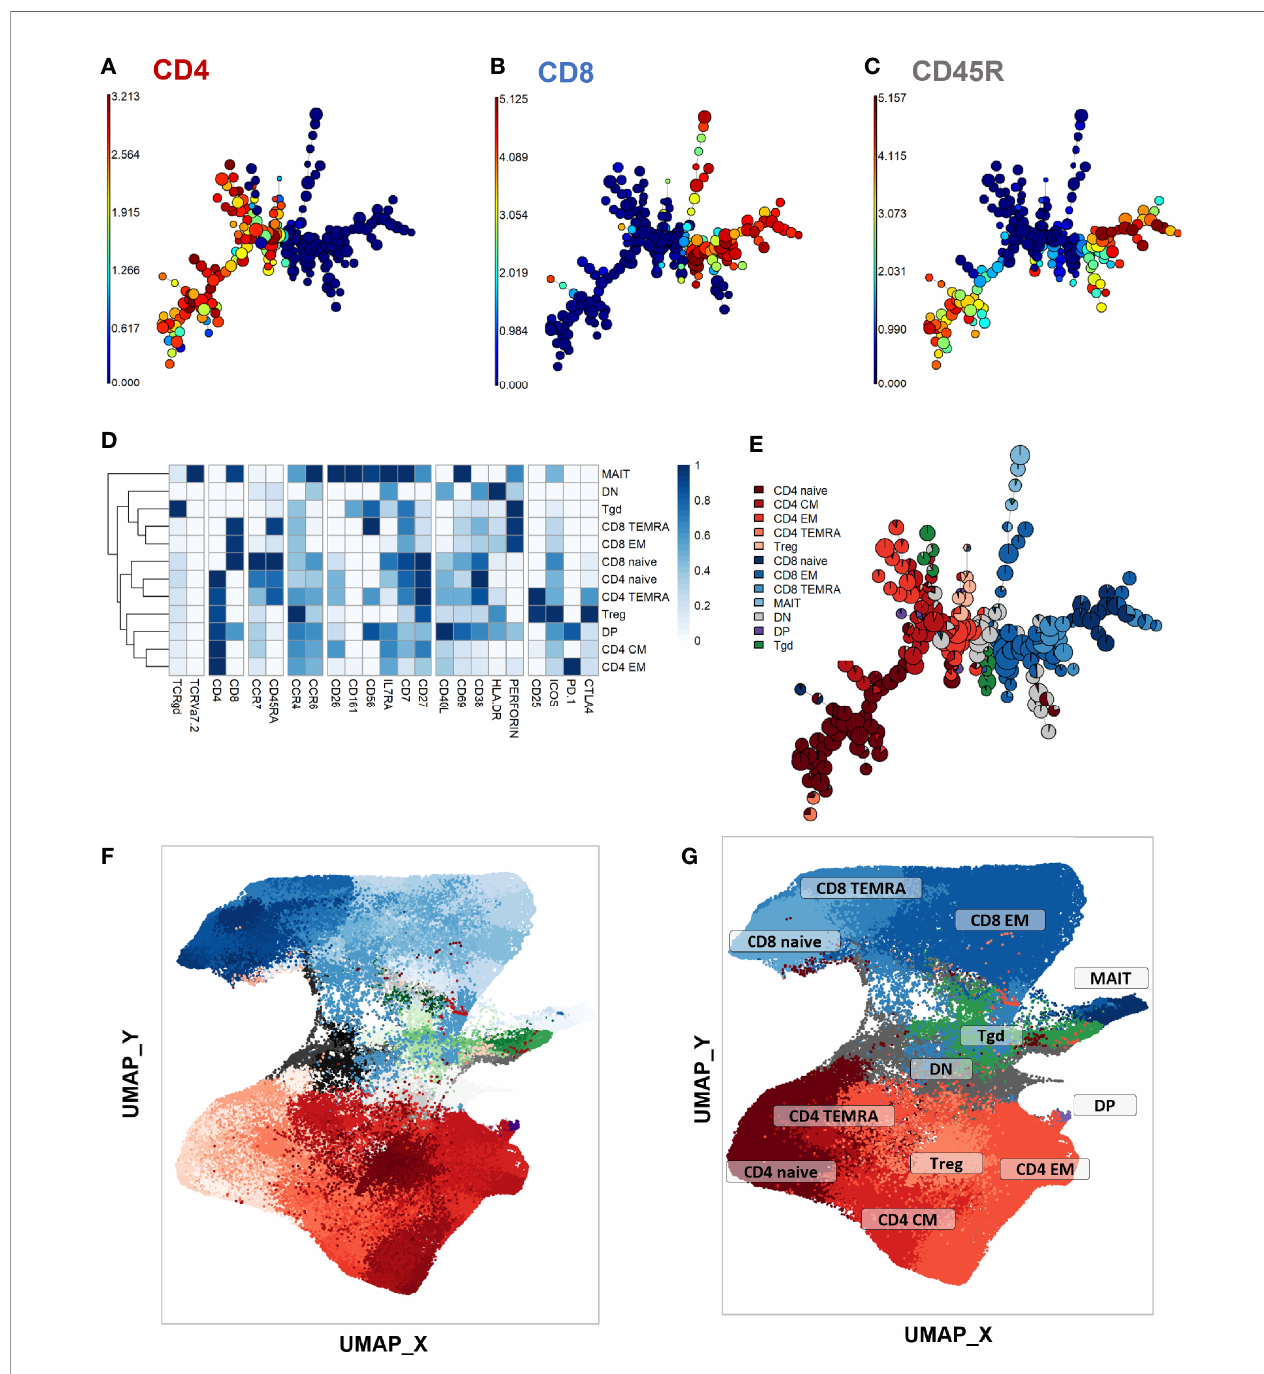
FIGURE 2 | Peripheral CD3 + T-cell unsupervised clustering and phenotyping. (A – E) FlowSOM automated clustering. The surface expression of lineage markers used for FlowSOM calculations was visualized in all CD3 + events (201,000 events from equally down-sampled fi les) regardless of timepoint or stimulation. FlowSOM enabled automated repartition of CD3 + events into 196 clusters according to the surface expression of selected lineage markers such as CD4 (A) , CD8 (B) , and CD45RA (C) . Scales indicate arcsinh-transformed mass signal values. Clusters were automatically grouped into 18 meta-clusters of homogeneous phenotype, which were assembled into 12 canonical T-cell subpopulations in a supervised manner after meta-cluster phenotyping. This was performed with heatmap visualization of normalized, arcsinh-transformed median mass signal values for each surface marker (D) . The proportions of the resulting T-cell subpopulations were visualized on the initial FlowSOM minimum spanning tree to control phenotyping consistency (E) . (F, G) Reference mapping. Dimension reduction was performed with UMAP and overlayed with automatically determined FlowSOM clusters (F) and meta-clusters (G) to generate a phenotype reference map. Cluster labels were not displayed for legibility. CM, central memory; DN, double-negative CD4 - CD8 - ; DN, double-positive CD4 + CD8 + ; EM, effector memory; MAIT, mucosal associated invariant T-cells; Tgd, gamma delta T-cells; Treg, T-regulators; TEMRA, terminally differentiated effectors re-expressing